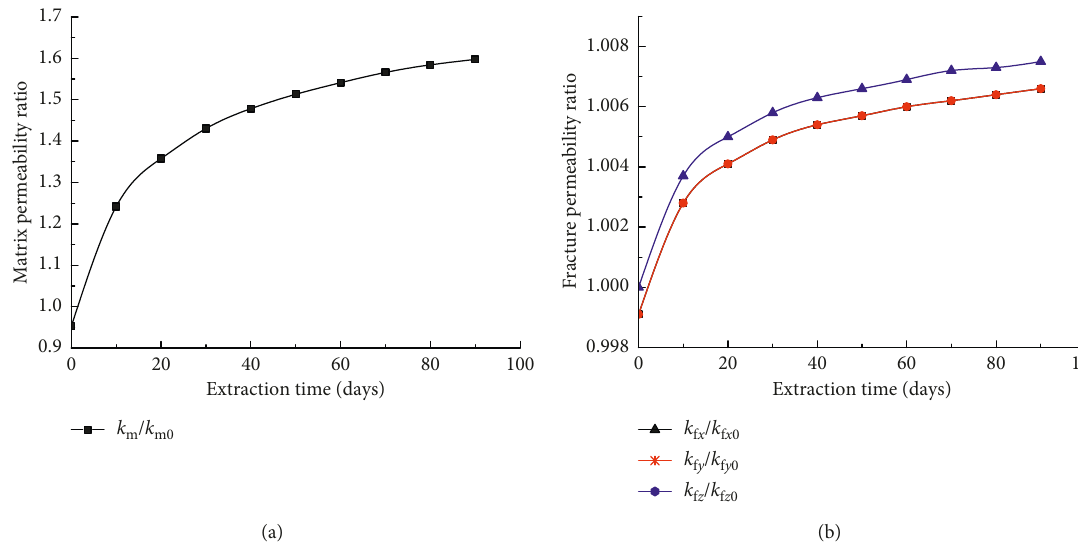
Figure 9: Permeability evolution with the anisotropic coefficient λ � 0.3. (a) Matrix permeability. (b) Fracture permeability.